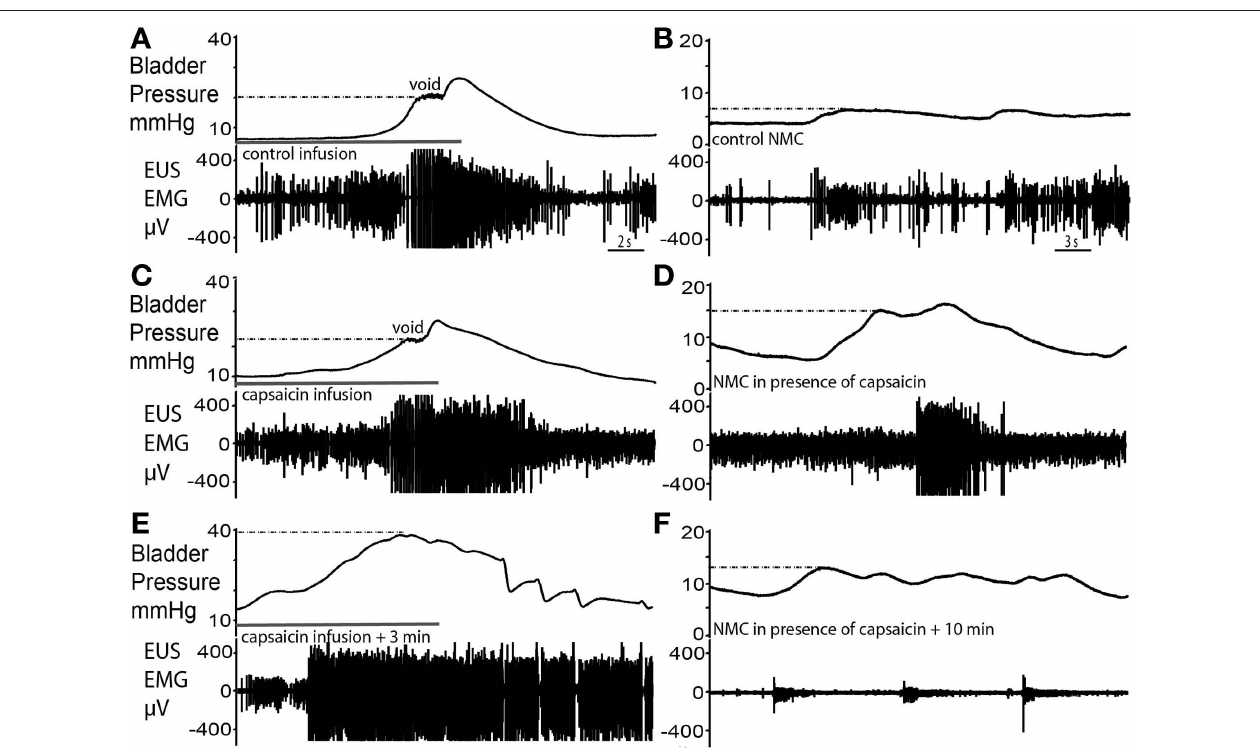
the volume had been administered and intravesical pressure had increased twofold above that seen during the control void. This infusion triggered a striking increase in the level of EUS–EMG activity as bladder pressure rose above 20 mmHg, previously the pressure at which voiding occurred. However, small incomplete voiding episodes were seen to occur at the highest pressures accompanied by irregular EUS bursting. Normal voiding responses were non recoverable. (F) The subsequent NMCs resulted in synchronous low level tonic firing, as the EUS was markedly